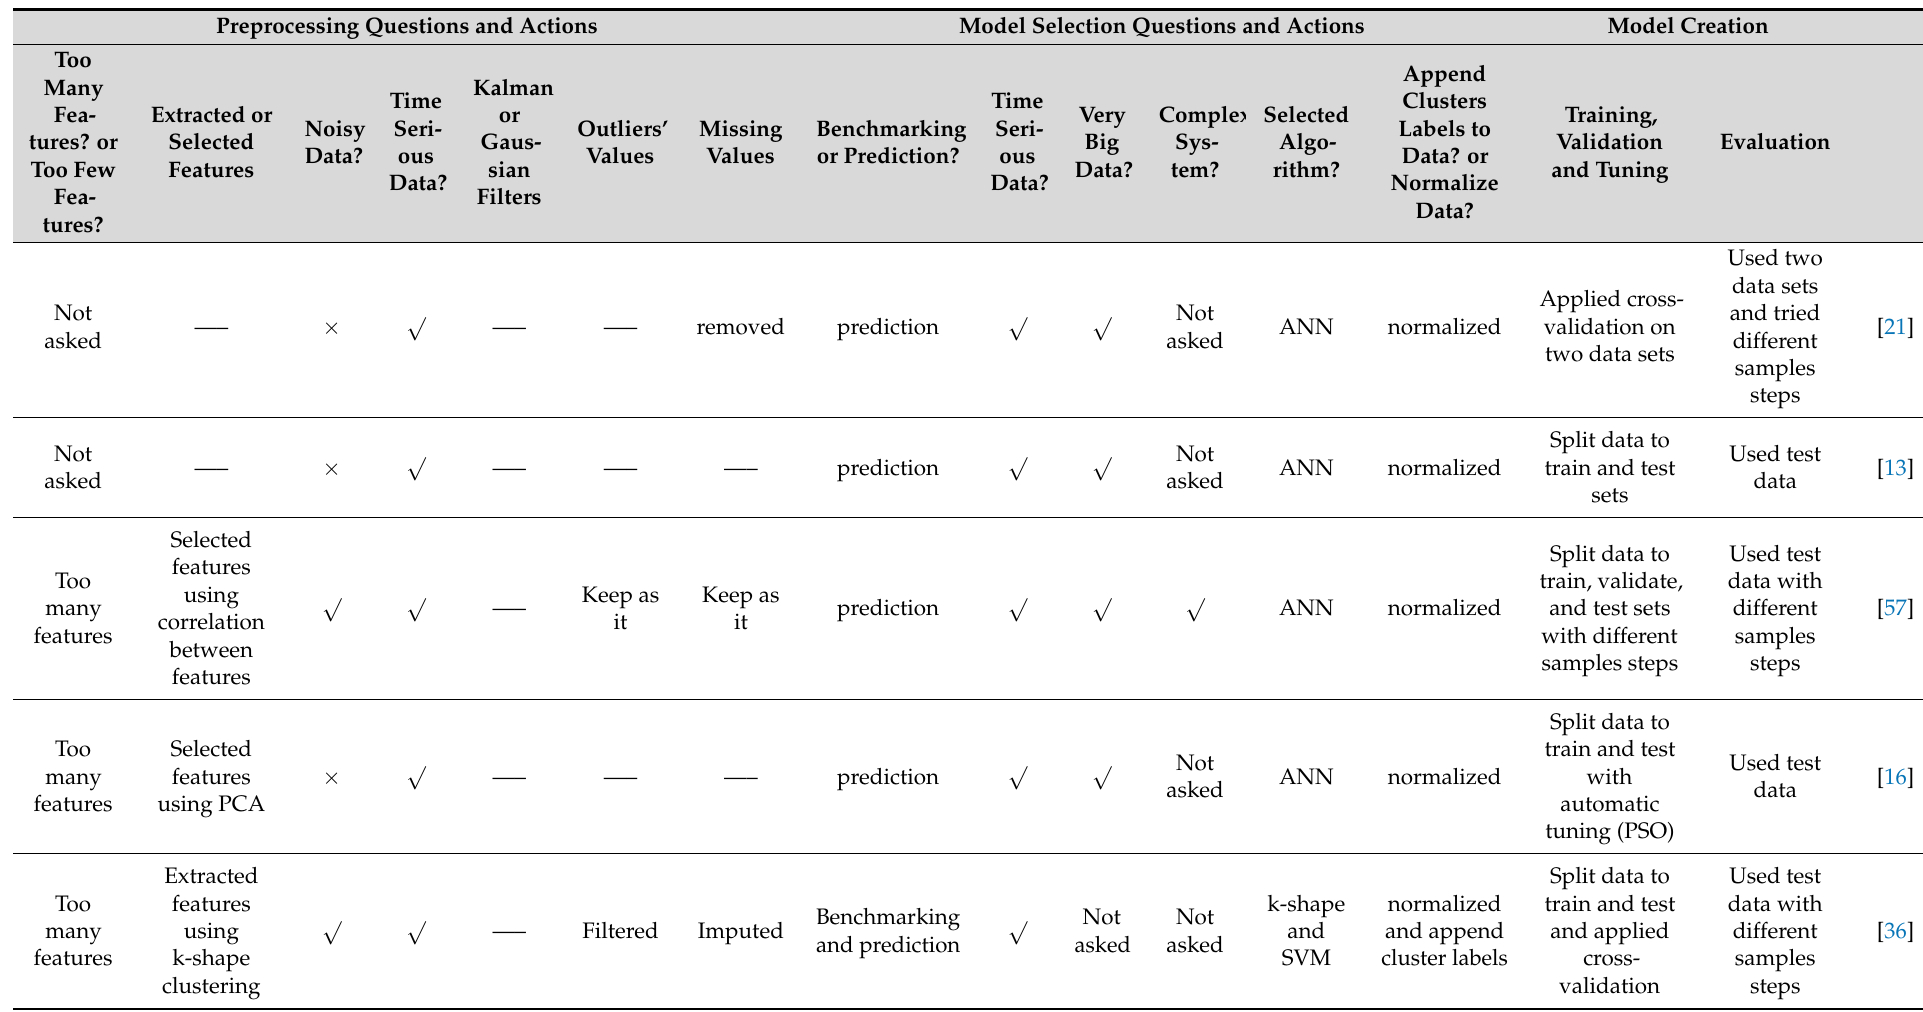
Table 1. Review of some previous papers comparing them with the proposed ML